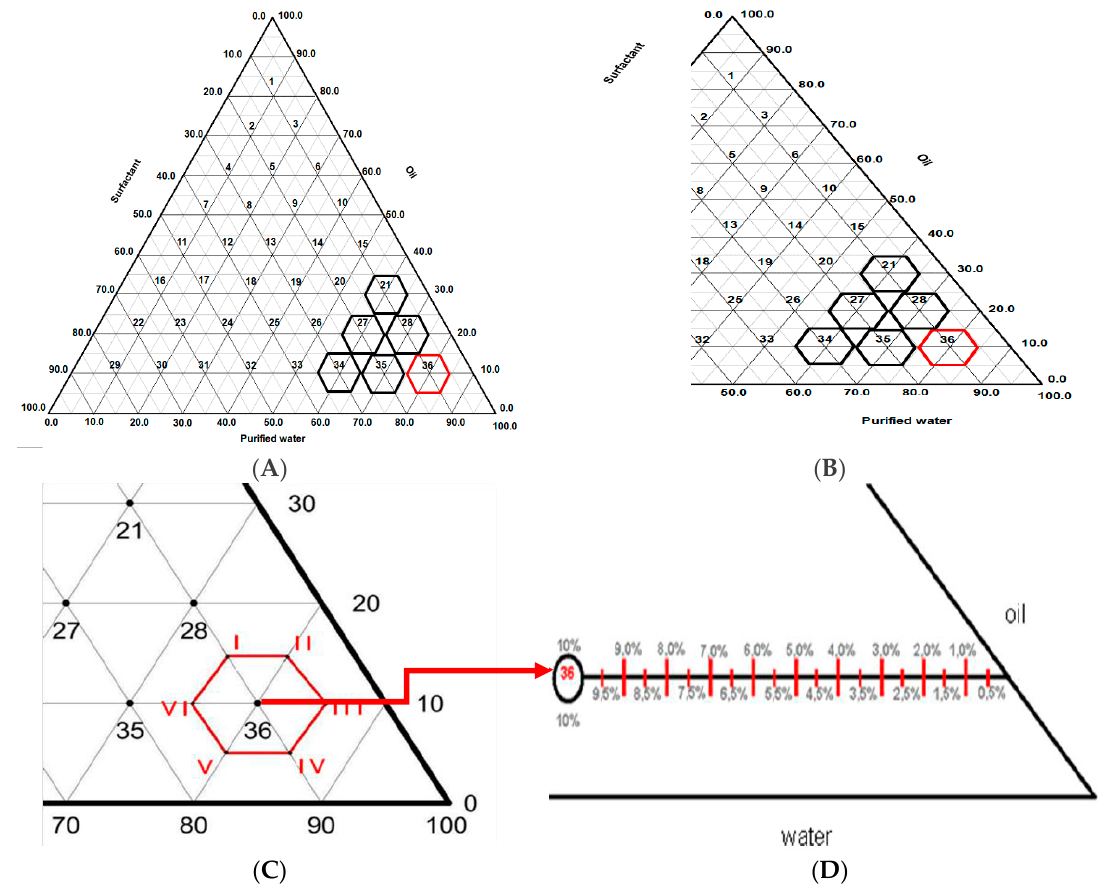
Figure 2. Derivatives of the formula 36 ( A ) pseudo-ternary diagram; ( B ) details of the pseudo-ternary diagram showing points 21, 27, 28, 34, 35 and 36; ( C ) derivative formulas around point 36; ( D ) maintaining the oil concentration, varying the water and decreasing the concentration of surfactant. Table 1. Composition (% w / w ) of derivatives of formula 36.